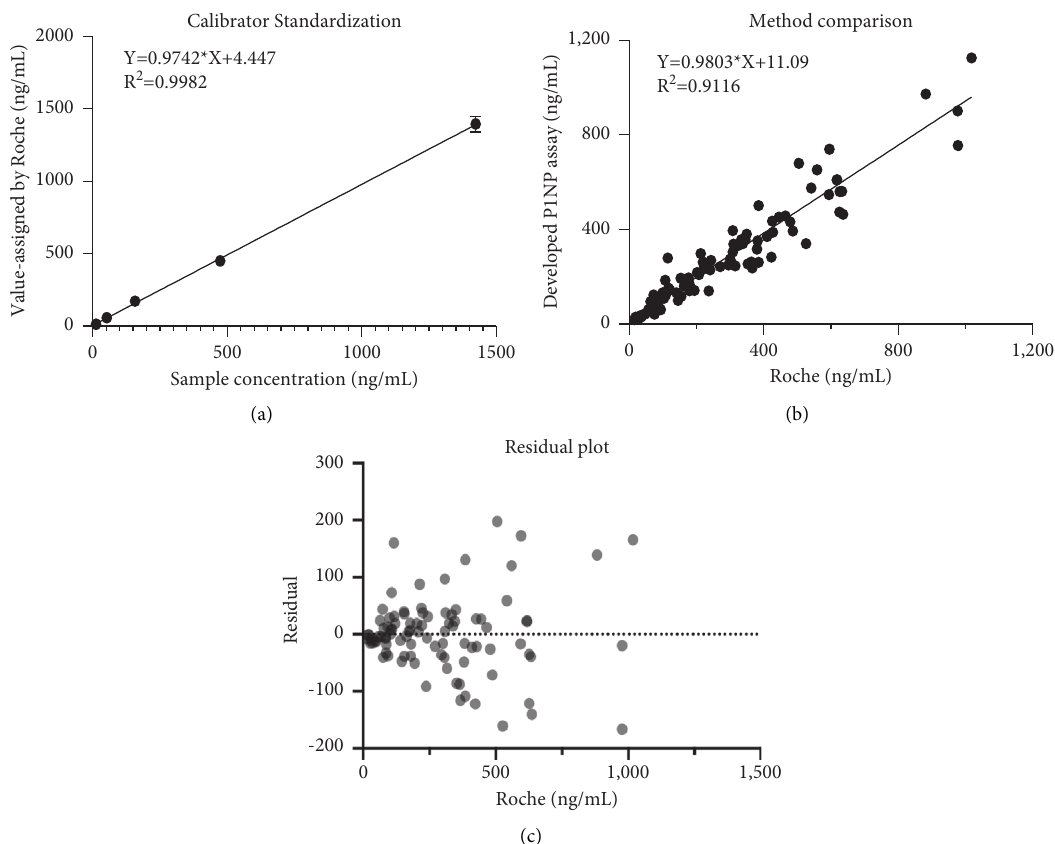
Figure 1: Basic performance evaluation of developed P1NP assay. (a) The calibrator standardization with Roche P1NP assay. The linear correlation of the sample and Roche has a slope of 0.9742. (b) The method comparison of our assay with the Passing–Bablok method between self-developed assay and Roche P1NP assay with slope 0.9803. 94 samples with a range from 15ng/mL to 1200ng/mL were included in this study. Dash line means 95% confidence interval. (c) The residual plot analysis of method comparison. The points state the deviation degree of the results obtained from self-developed assay and Roche P1NP assay. The farther the points deviate from zero line means, the larger the deviation exists between the two